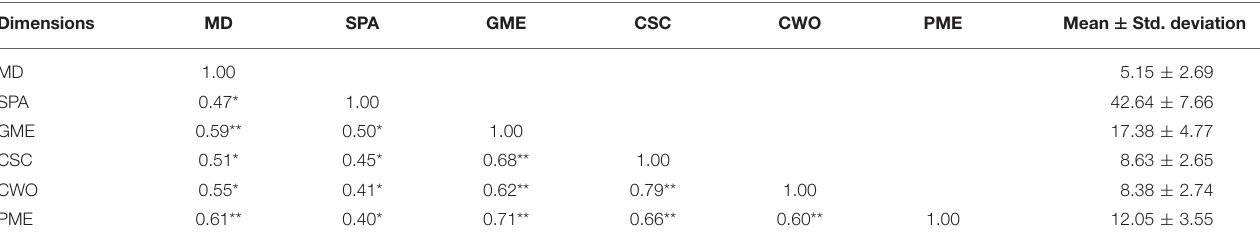
TABLE 5 | Descriptive statistics and Pearson product-moment correlation across muscle dysmorphia, social physique anxiety, and body checking behaviors ( N = 492).